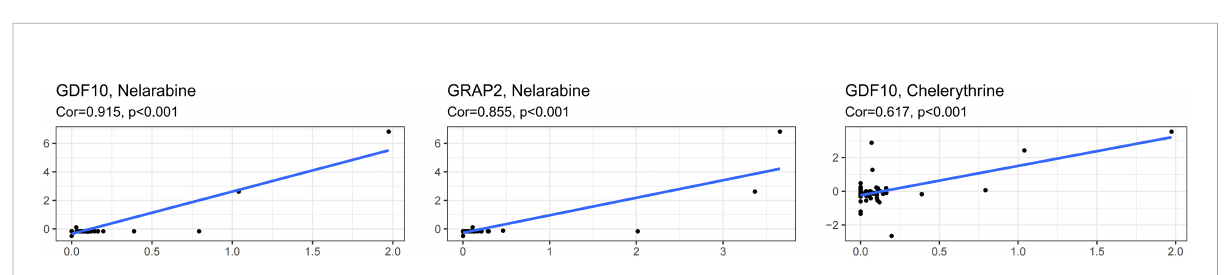
FIGURE 11 Correlation between IRS RNA-expression and drug sensitivity as derived from the NCI-60 cancer cell